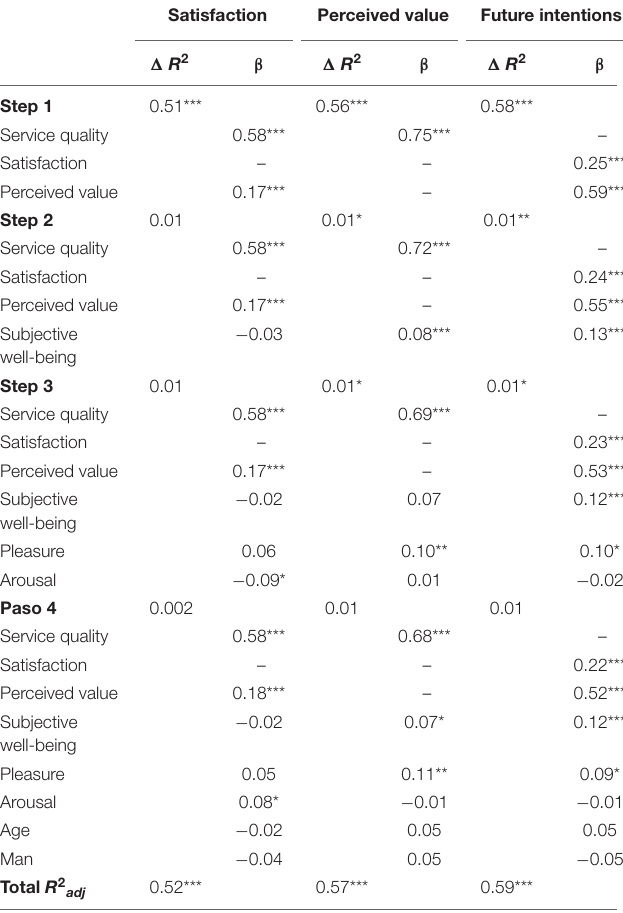
TABLE 1 | Hierarchical regression models of management variables, customer emotions, subjective well-being, age and sex in satisfaction, perceived value, and future